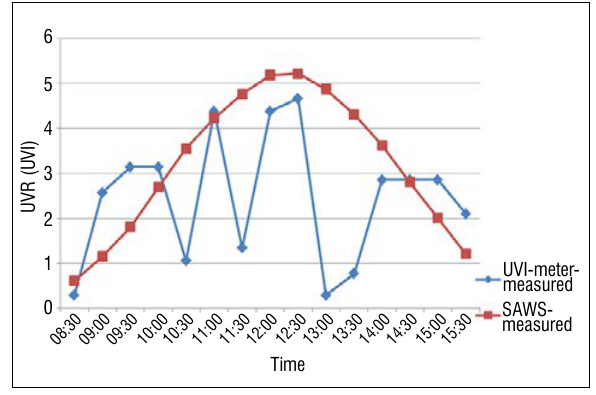
Figure 1: Solar ultraviolet radiation (UVR) on Day 1 measured as an ultraviolet index (UVI) by a handheld device on site and a biometer at the South African Weather Service (SAWS).